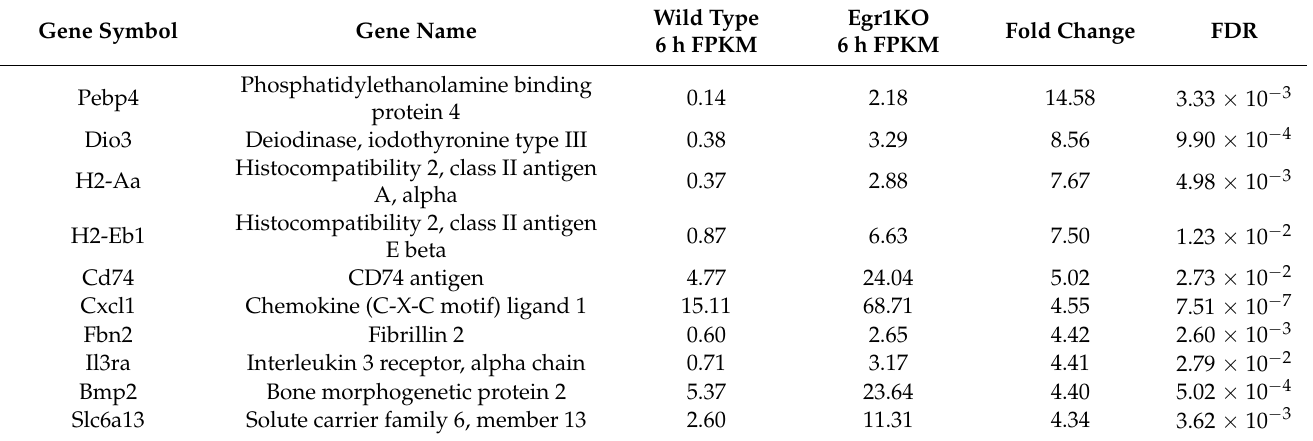
Table 4. Topmost upregulated DEGS in Egr1KO LECs at 6 h PCS.